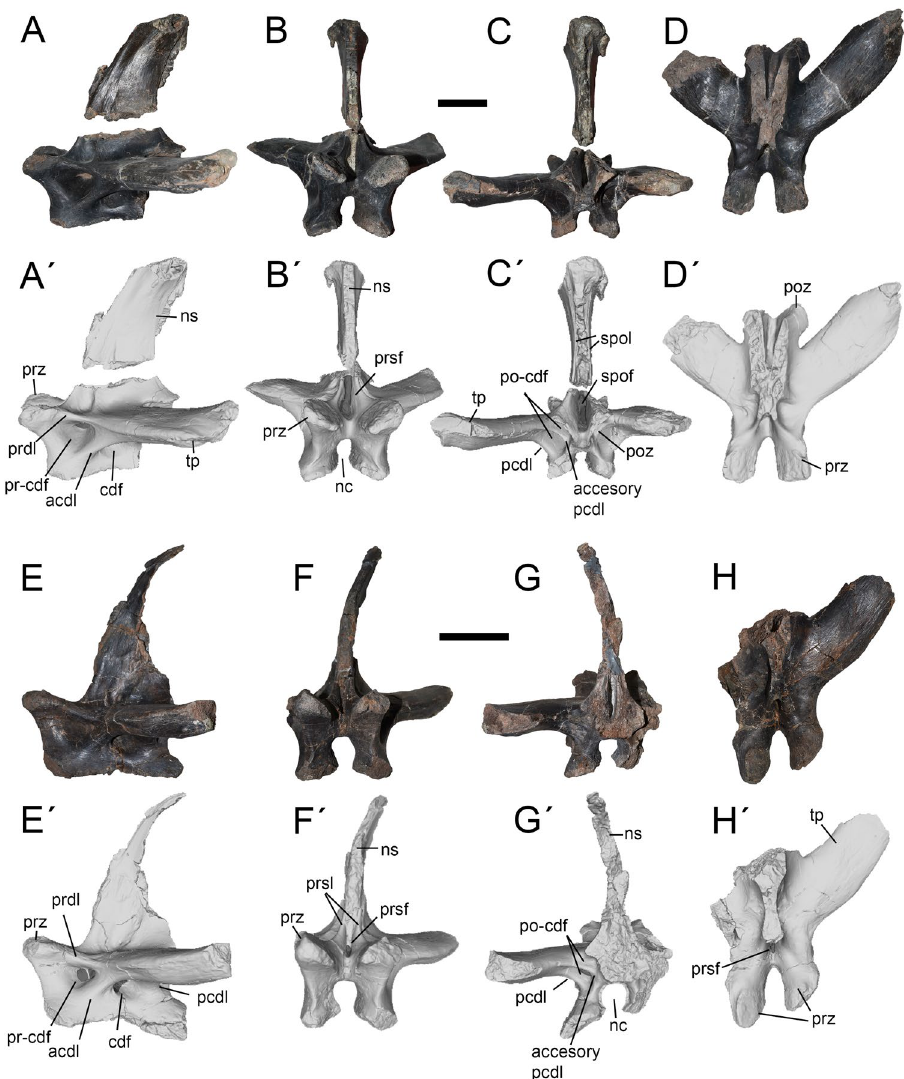
Figure 9. Caudal fourth ( A - D ) and caudal seventh ( E – H ) of Maip . Lateral ( A, A´, E, E´ ), anterior ( B, B´, F, F´ ), posterior ( C, C´, G, G´ ) and dorsal ( D, D´, H, H´ ) views. Scale bar: 5 cm. Abbreviations: acdl; anterior centrodiapophyseal lamina; accessory pcdl, accessory posterior centrodiapophyseal lamina; cdf; centrodiapophyseal fossa; nc, neural canal; ns, neural spine; pcdl; posterior centrodiapophyseal lamina; poz, postzygapophyses; po-cdf; postzygapophyseal-centrodiapophyseal fossa; prdl; prezygodiapophyseal lamina; prsf; prespinal fossa; prsl, prespinal lamina; prz, prezygapophyses; pr-cdf; prezygapophyseal-centrodiapophyseal fossa; spof; spinopostzygapophyseal fossa; spol; spinopostzygapophyseal lamina; tp, transverse